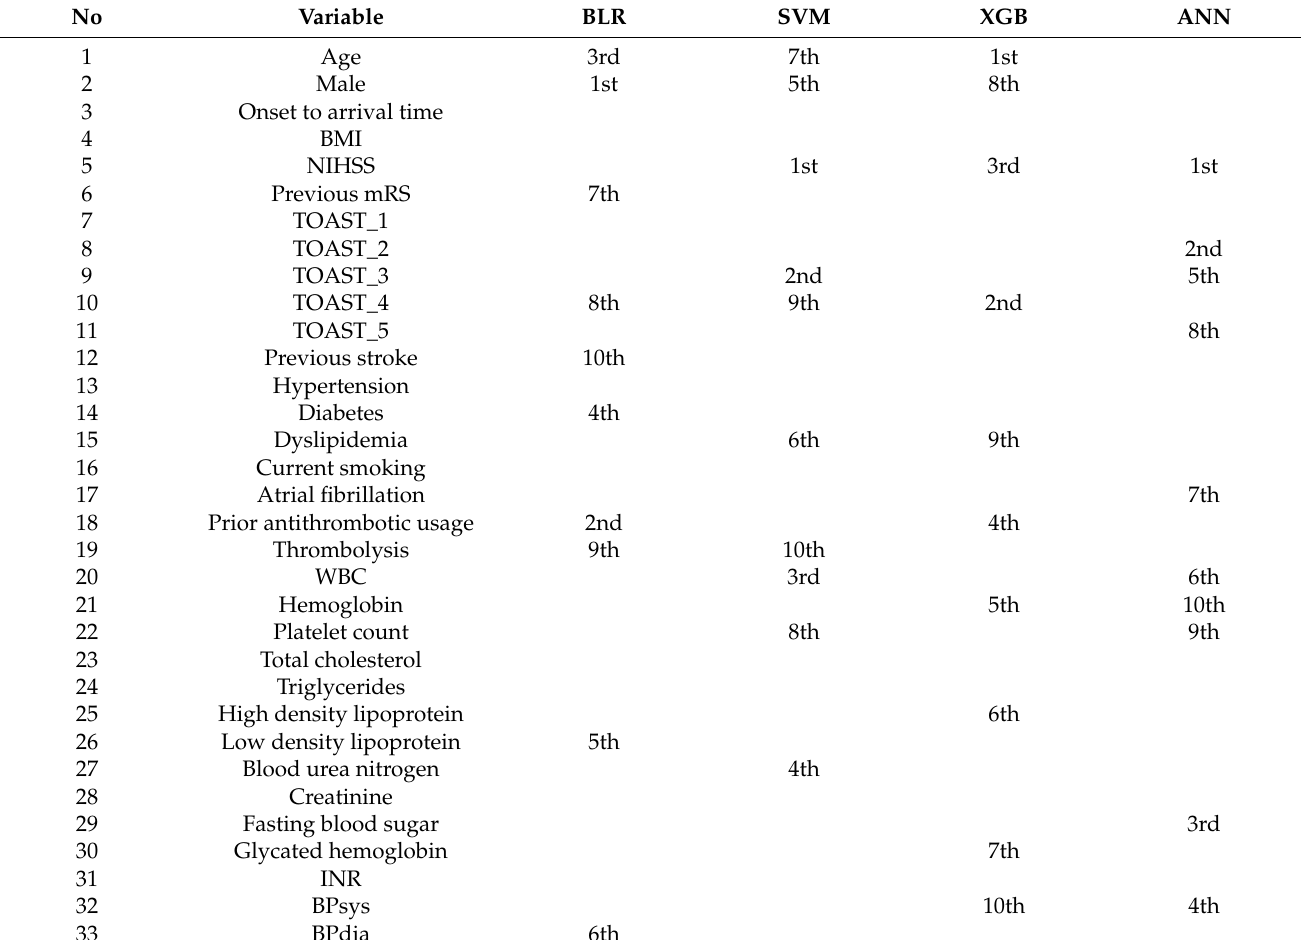
Table 3. Most important input variables of predicting hemorrhagic transformation after acute ischemic stroke in each machine learning